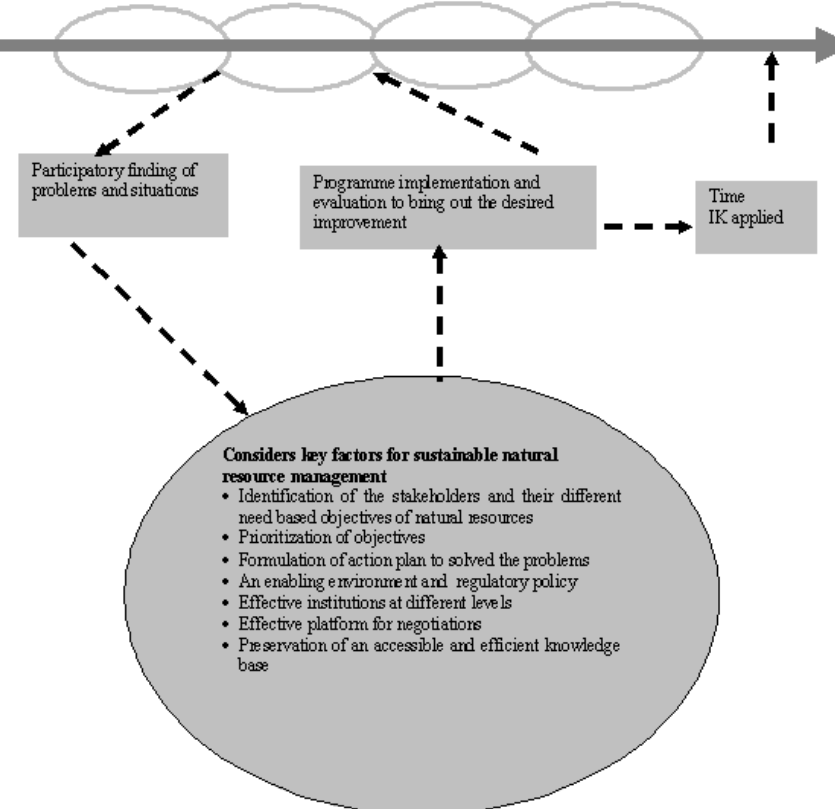
Fig 4 Basic structure of an IK-based sustainable natural resource management and development